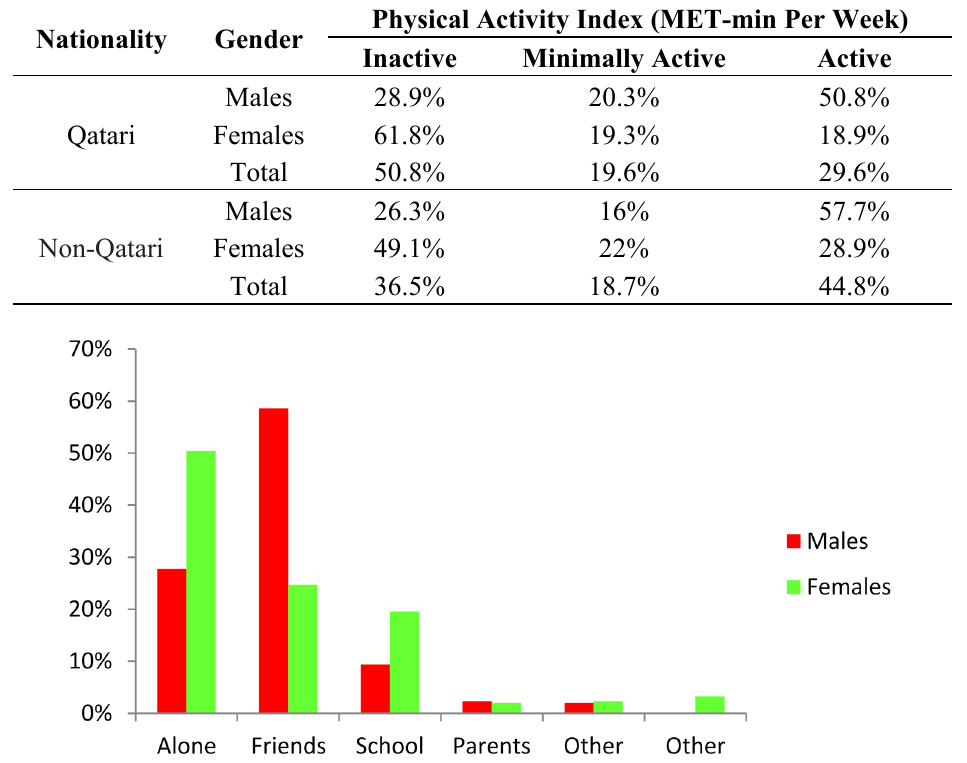
Table 3. Levels of physical activity in Qatari and non-Qatari males and females.